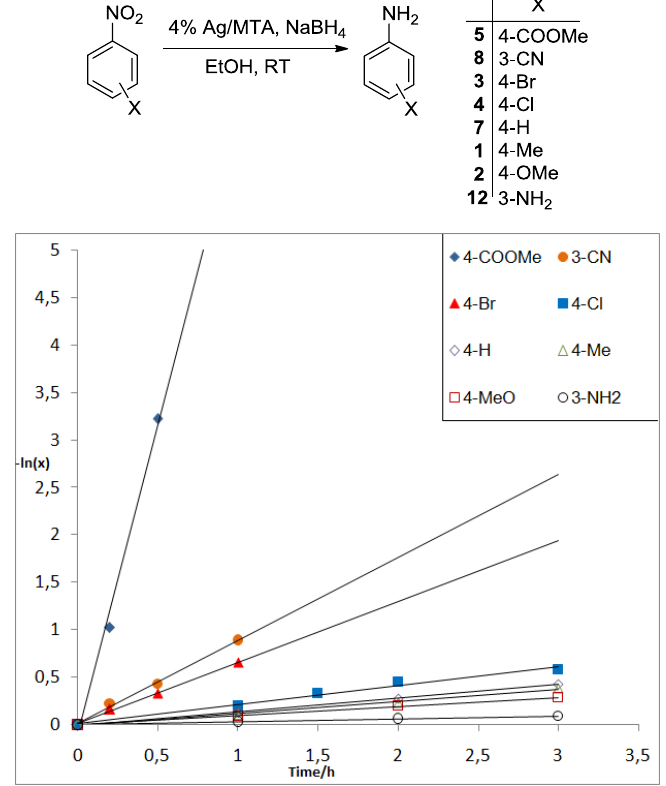
Figure 2. Kinetic analysis of the 4% Ag/MTA-catalyzed reduction of various X -substituted nitroarenes (X = 3-NH 2 ( 12 ), 4-MeO ( 2 ), 4-Me ( 1 ), 4-Br ( 3 ), 4-H ( 7 ), 4-Cl ( 4 ), 3-CN ( 8 ) and 4-COOMe ( 5 )) with NaBH 4